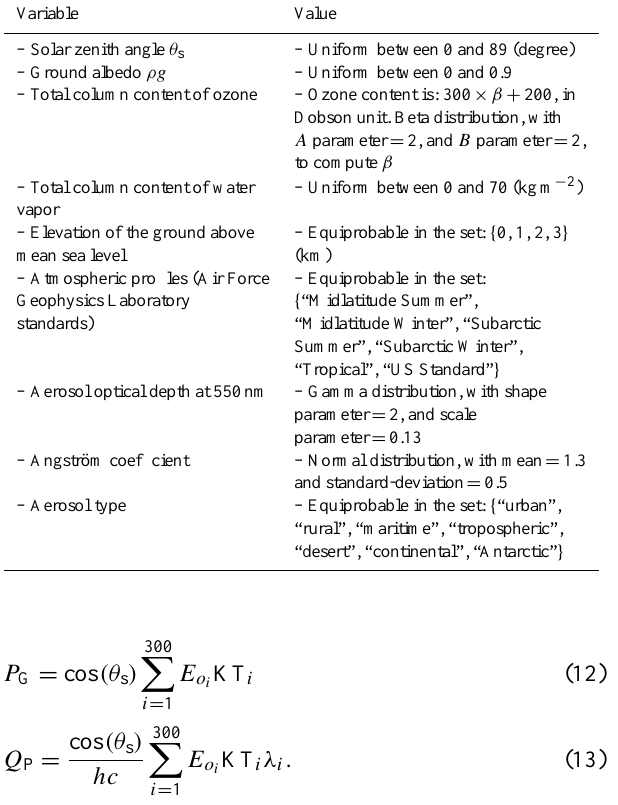
Table 2. Ranges and distributions of values taken by the solar zenith angle, the ground albedo and the 7 variables describing the clear